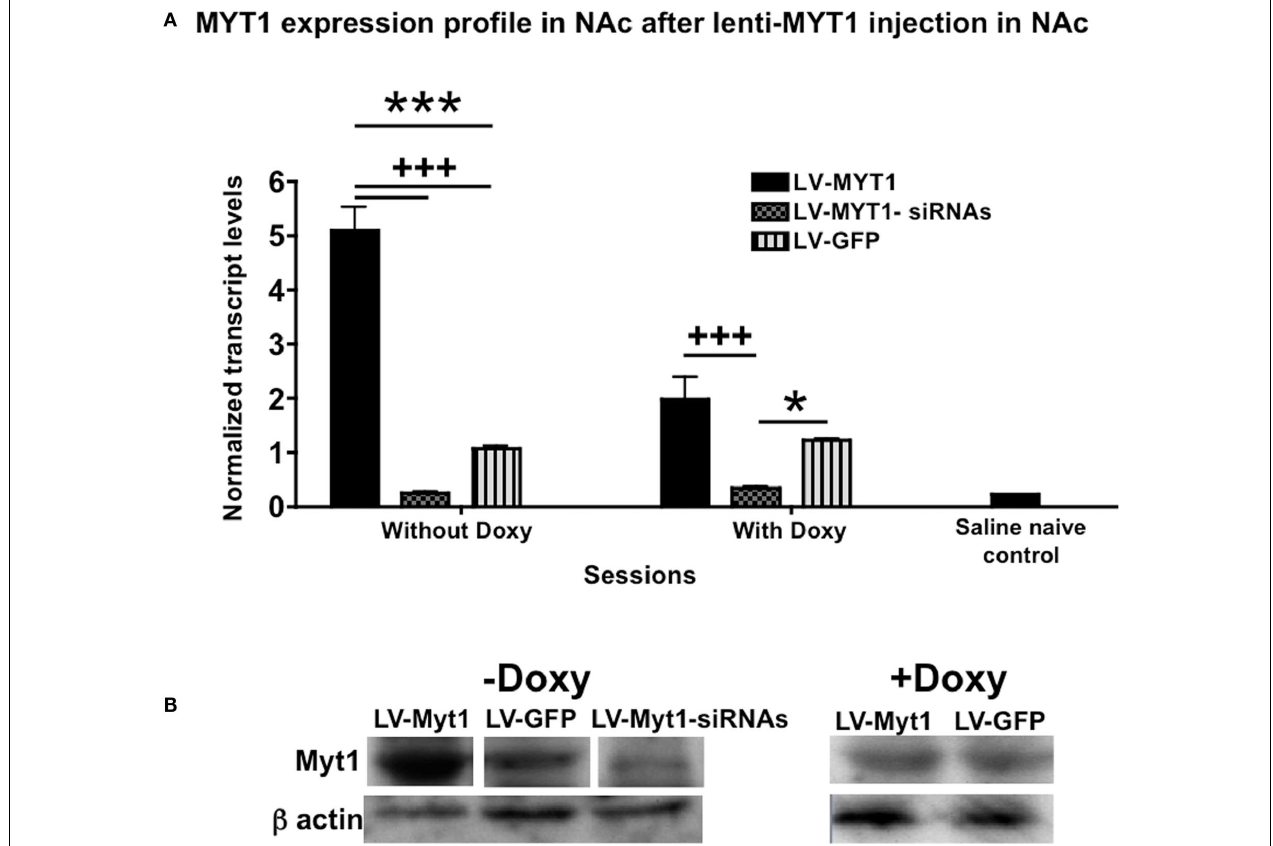
FIGURE 3 | NZF-2b/7ZFMyt1 expression in the NAc after cocaine self- administration. (A) NAc samples were retrieved after the end of the behavioral studies (cocaine self-administration) from animals fed either with or without doxycycline. NZF-2b/7ZFMyt1 mRNA expression levels were determined by qRT-PCR relative to Cyclophilin. LV-7ZFMyt1 group displayed increased expression of NZF-2b/7ZFMyt1 compared to LV-GFP control, whereas in LV-7ZFMyt1-siRNA group a signifi cant decrease in NZF-2b/7ZFMyt1 expression compared to LV-GFP was observed. Doxycycline regimen that inhibits ectopic expression resulted in a signifi cant decrease in NZF-2b/7ZFMyt1 levels in the LV-7ZFMyt1 group. * P < 0.05; ** P < 0.01; *** P < 0.001 represents values signifi cantly different from LV-GFP group, and + P < 0.05; ++ P < 0.01; +++ P < 0.001 results in nuclear localization of NZF-2b/7ZFMyt1, predominantly in neurons (Chandrasekar and Dreyer, 2010). These observa- tions were further analyzed after self-administration ( Figure 4 ).